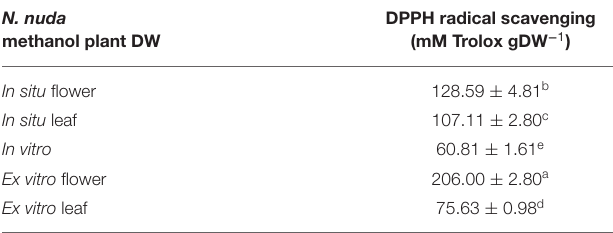
TABLE 1 | Antioxidant activity of N. nuda crude methanol